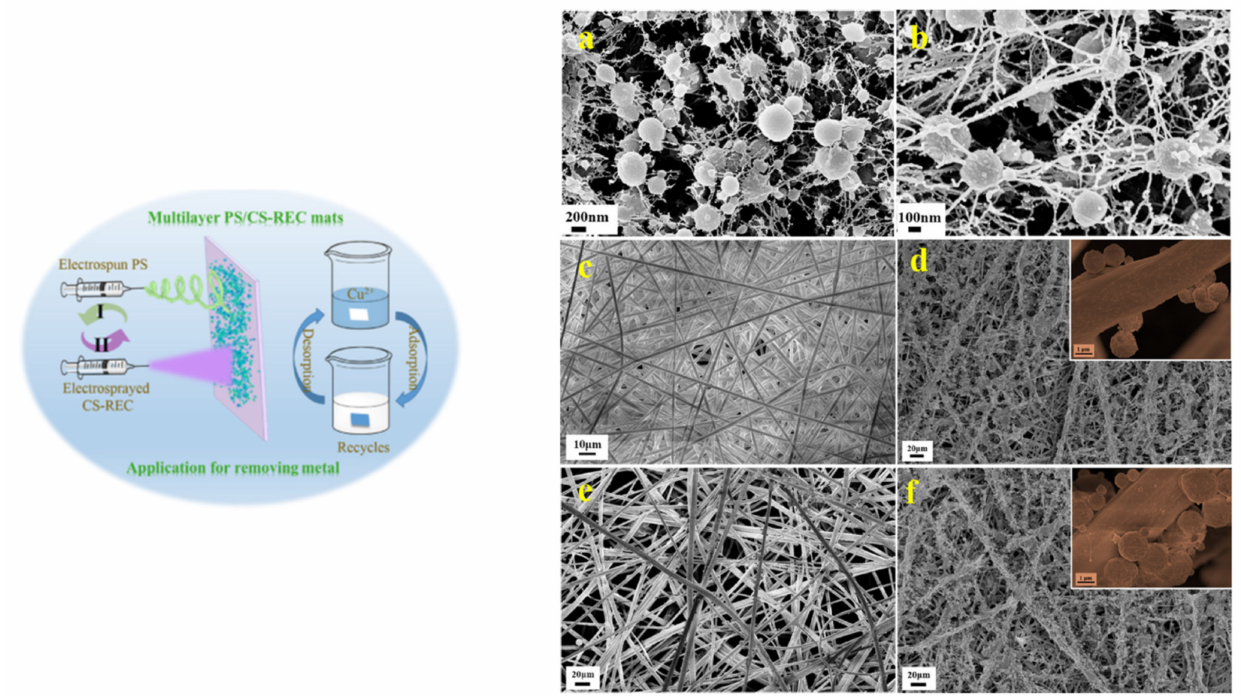
Figure 14. SEM images of nanofibers and composite nanofibers obtained by PS electrospinning alternately with CS-rectorite electrospraying: ( a ) CS, ( b ) CS-rectorite, ( c ) PS, ( d ) PS/CS-rectorite, ( e ) (PS/CS-rectorite) 1.5 and ( f ) ((PS/CS-rectorite) 2 (reprinted with permission from ref.